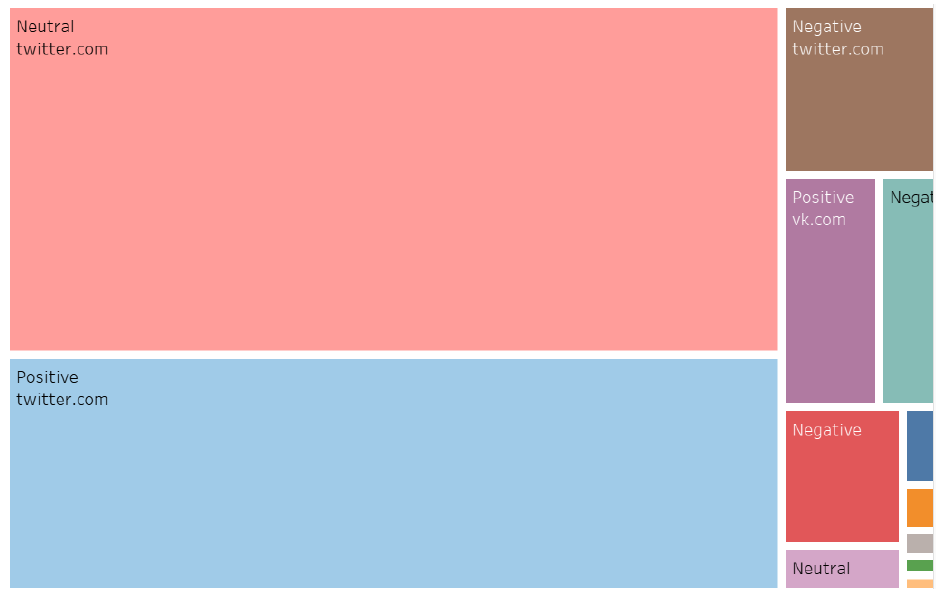
Figure 6. Sentiment consolidated database on various digital platforms.